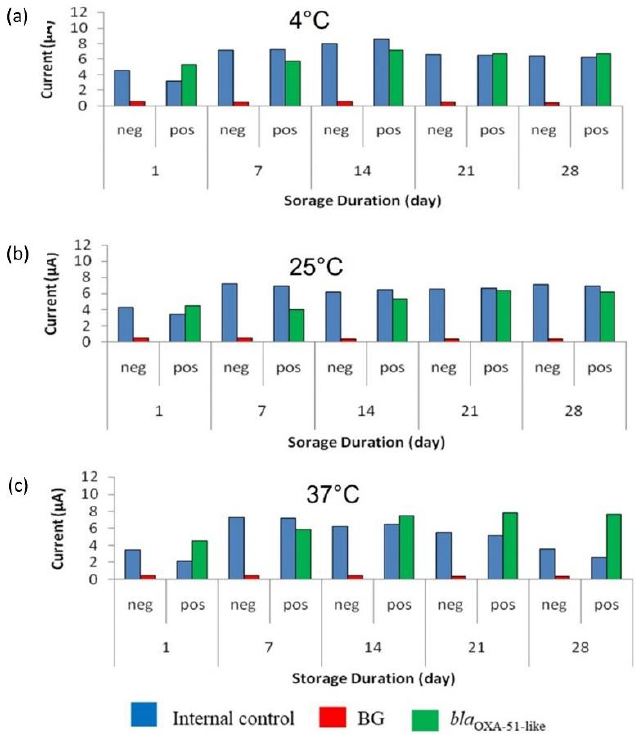
Figure 6. Stability evaluation of the modified screen-printed carbon electrodes (SPCEs) with 6% trehalose for 28 days at ( a ) 4 °C, ( b ) 25 °C, and ( c ) 37 °C. BG: Background control without using bacterial strains.